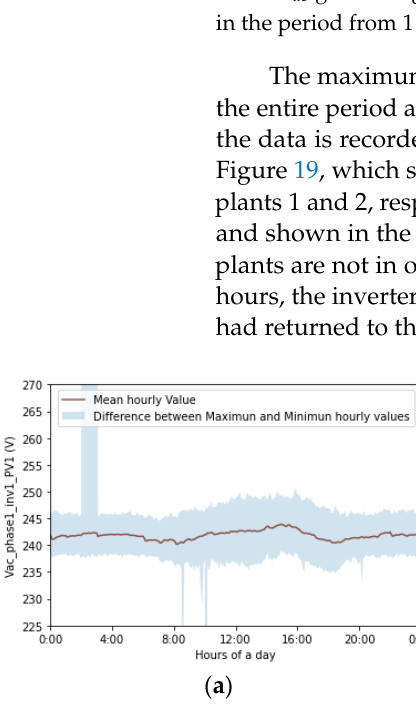
Figure 19. Average values (brown) and the difference between daily maximum and minimum (blue) for the period from 1 November 2020 to 4 July 2022 of the V ac grid voltage measured in phase 1 by inverter 1 of plant 1 ( a ) and inverter 10 of plant 2 ( b ), in each of the 288 daily records, with a frequency of 5 min.